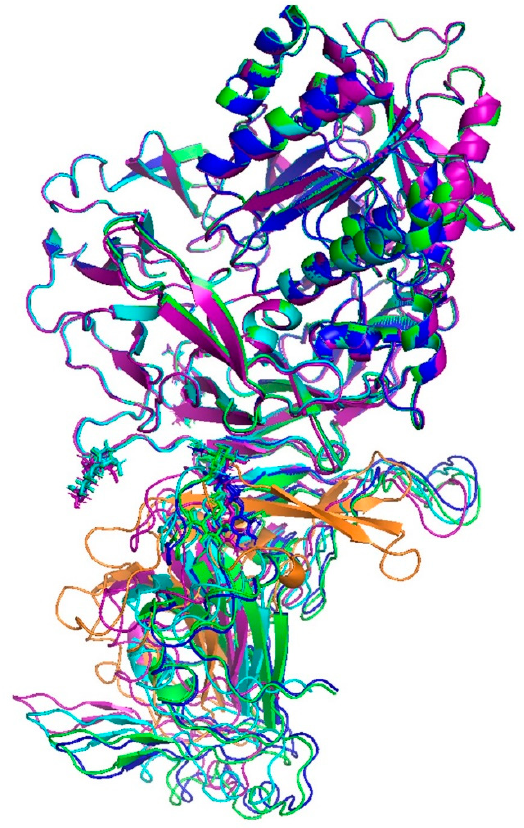
Figure 5. Predicted binding poses between the remodelled structure of the RBD of SARS-CoV-2 and DPP4 obtained using flexible molecular docking with HADDOCK. For comparison, the structure of the RBD of MERS-CoV (orange) is superimposed. Different poses are coloured in cyan, purple, blue and green.